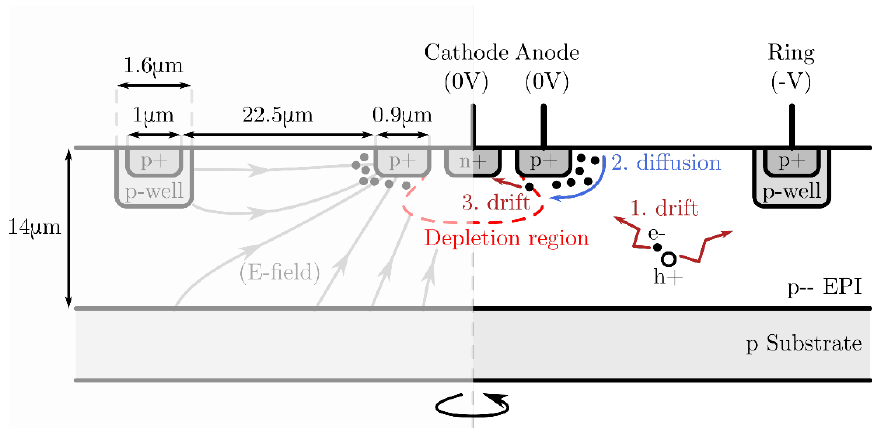
Figure 6. The layout and dimensions of the fabricated current-assisted photodiode. The center cath- ode n + region is 1.5 µm in diameter, keeping 0.75 µm space with the anode p + region. The ring is cathode n + region is 1.5 µ m in diameter, keeping 0.75 µ m space with the anode p + region. The ring is biased to a negative bias voltage. biased to a negative bias voltage.